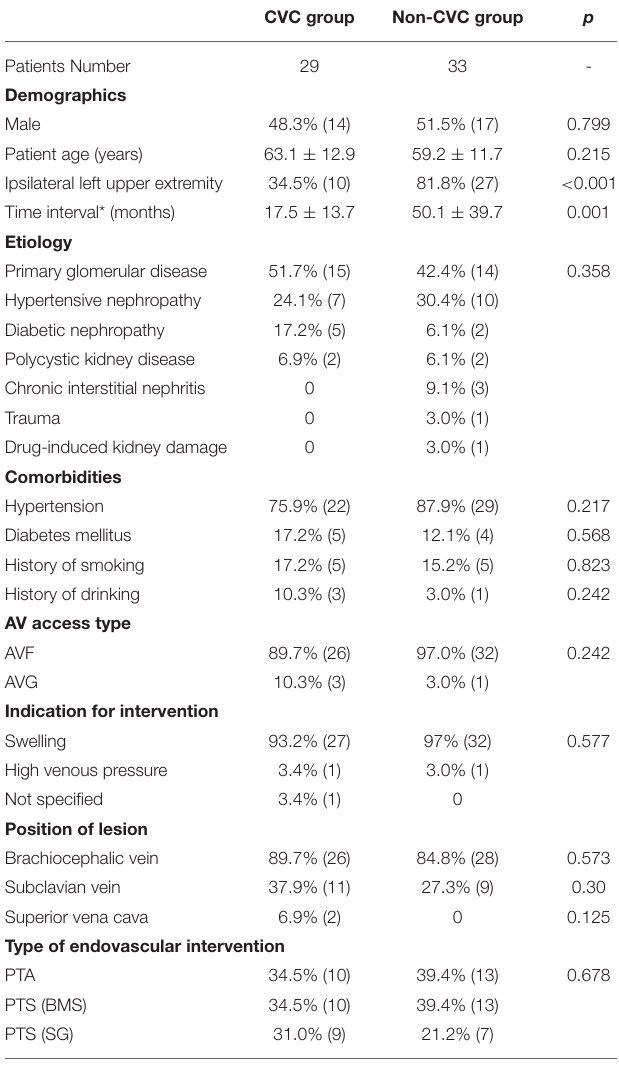
TABLE 1 | Baseline characteristics of the